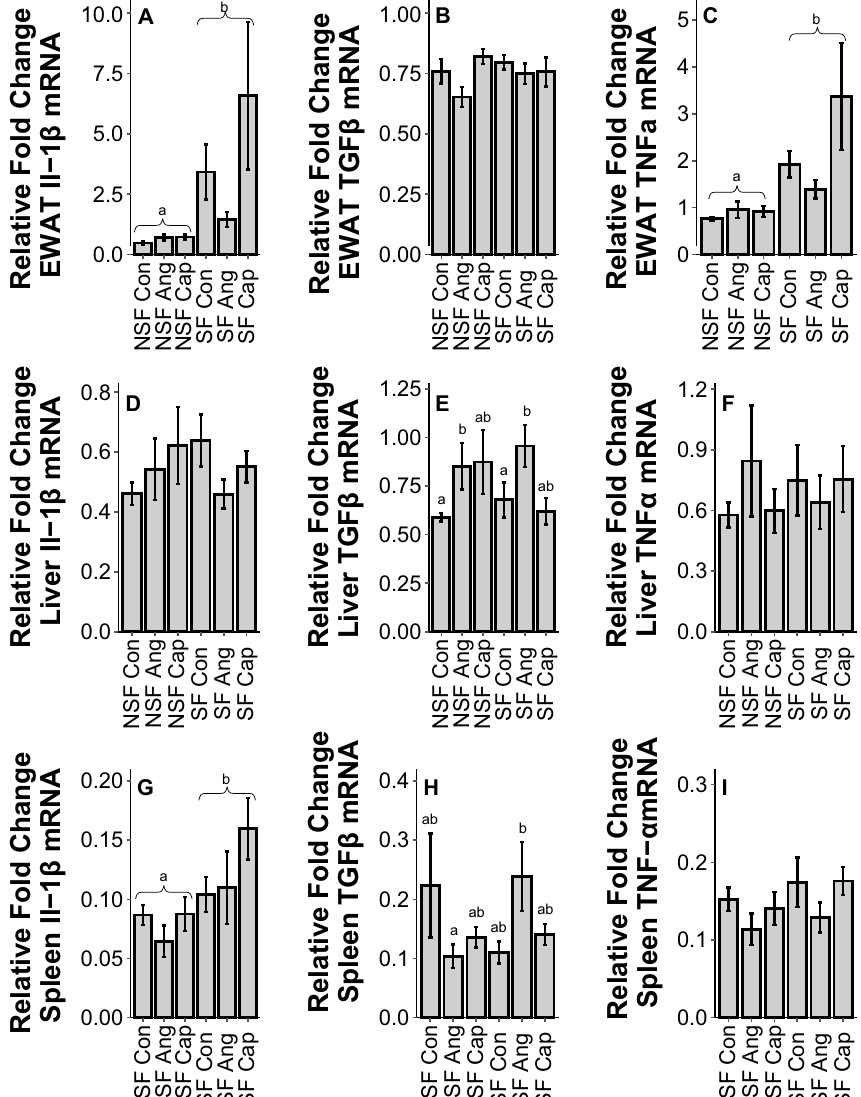
Figure 1. Effects of sleep fragmentation, RAS manipulation, and their interaction on Il-1β, TGFβ, and TNFα gene expression in peripheral tissues, epididymal white adipose tissue (EWAT; A , B , C ), liver ( D , E , F ), and spleen ( G , H , I ). Samples sizes are ( A , B ) NSF-Con n = 11, NSF-Ang n = 10, NSF-Cap n = 9, SF-Con n = 10, SF-Ang n = 9, and SF-Cap n = 9, ( C ) NSF-Con n = 11, NSF-Ang n = 10, NSF-Cap n = 10, SF-Con n = 10, SF-Ang n = 9, and SF-Cap n = 9, ( D ) NSF-Con n = 10, NSF-Ang n = 9, NSF-Cap n = 10, SF-Con n = 10, SF-Ang n = 8, and SF-Cap n = 10, ( E ) NSF-Con n = 10, NSF-Ang n = 9, NSF-Cap n = 10, SF-Con n = 9, SF-Ang n = 9, and SF-Cap n = 9, ( F ) NSF-Con n = 11, NSF-Ang n = 9, NSF-Cap n = 10, SF-Con n = 10, SF-Ang n = 9, and SF-Cap n = 10, ( G ) NSF-Con n = 10, NSF-Ang n = 9, NSF-Cap n = 9, SF-Con n = 10, SF-Ang n = 9, and SF-Cap n = 9, ( H ) NSF-Con n = 10, NSF-Ang n = 9, NSF-Cap n = 8, SF-Con n = 10, SF-Ang n = 8, and SF-Cap n = 9, ( I ) NSF-Con n = 10, NSF-Ang n = 9, NSF-Cap n = 9, SF-Con n = 10, SF-Ang n = 8, and SF-Cap n = 9. All data were analyzed using a two-way ANOVA and Tukey’s HSD post hoc tests. Data shown as means ± 1 SE for each group and differing lowercase letters denotes p <